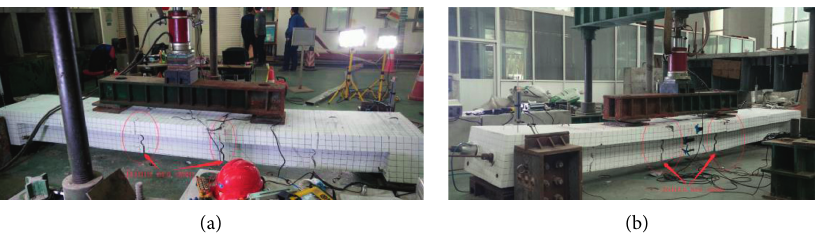
Figure 5: Specimens under the final step loading: (a) specimen 1; (b) specimen